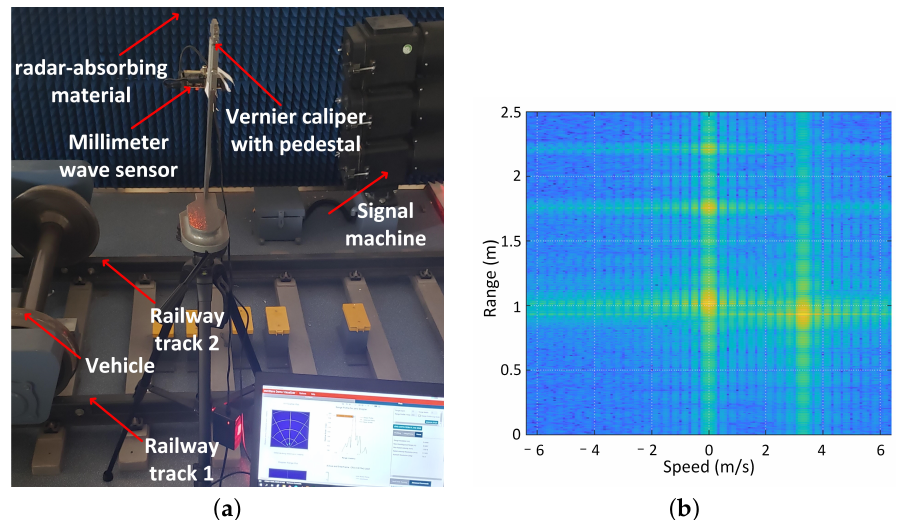
Figure 8. Photograph and range doppler heat map of the experimental environment for track settle- ment measurement. ( a ) photograph of the experimental environment; ( b ) range doppler heat map.